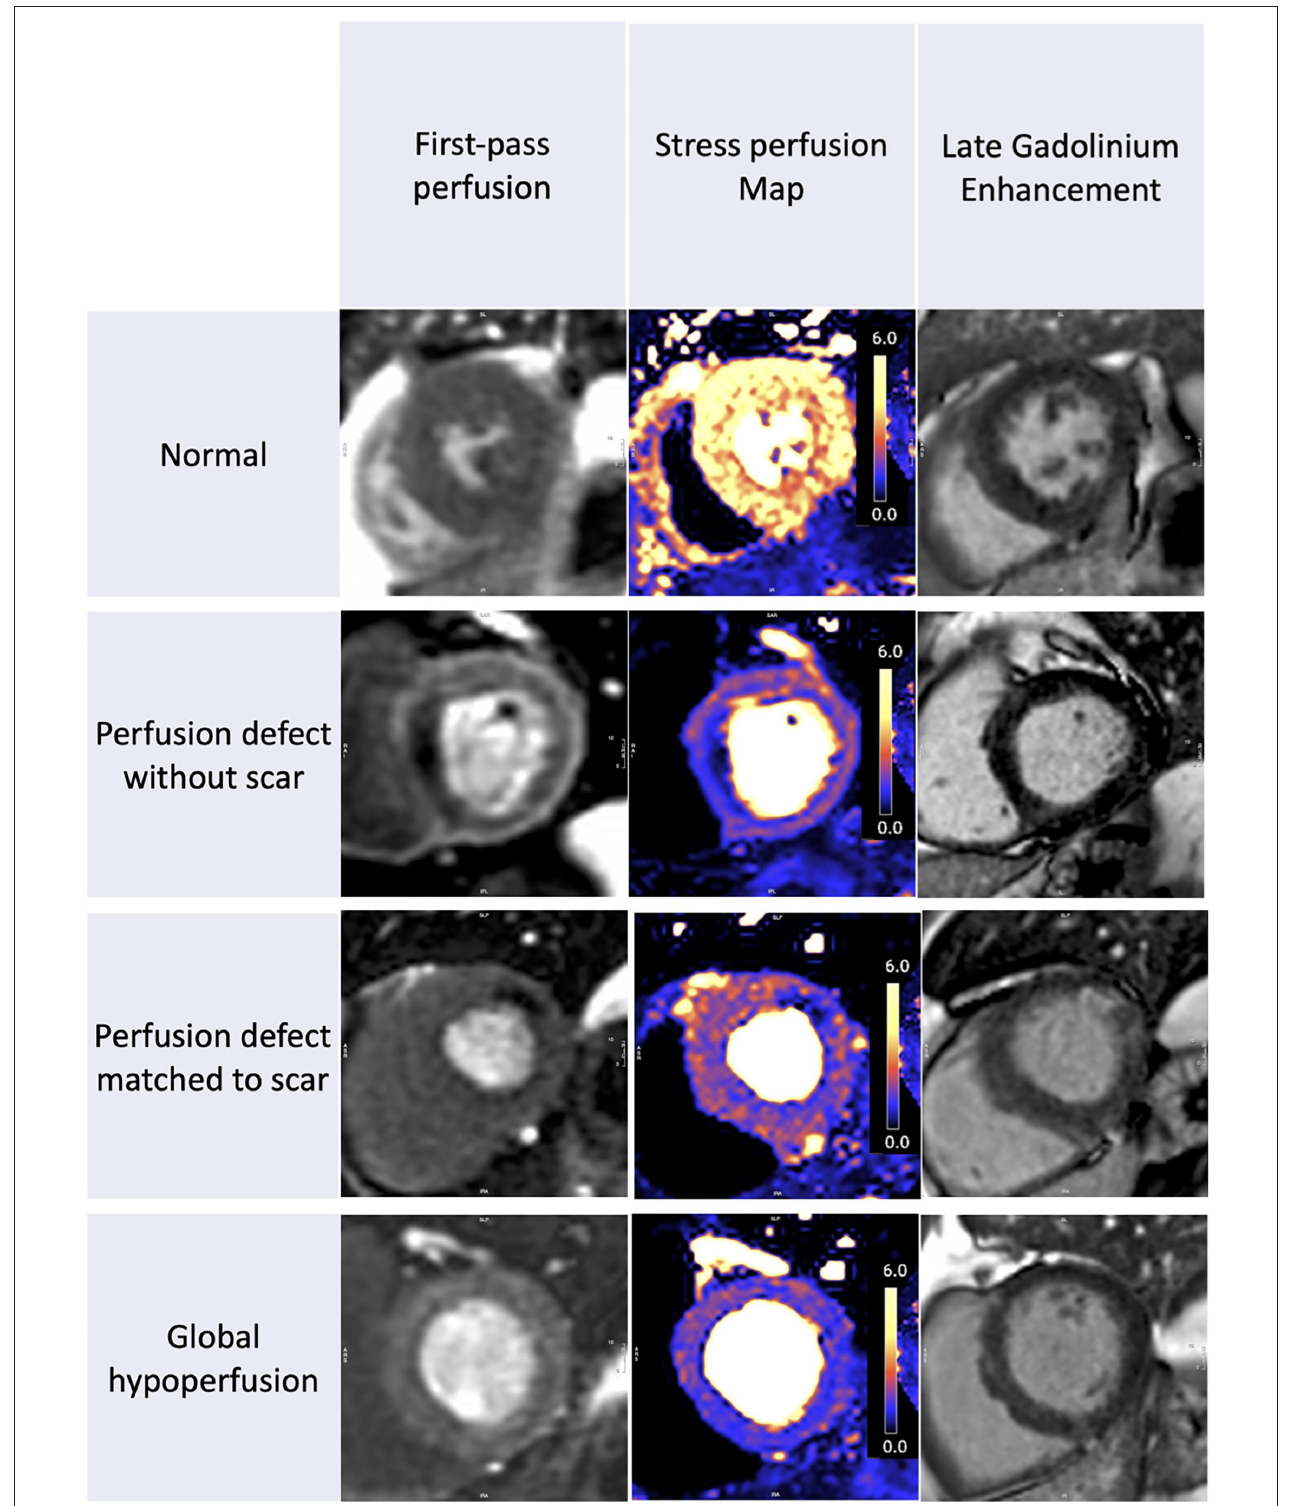
FIGURE 1 | Stress perfusion and scar in recovered COVID-19 patients. The spectrum of perfusion abnormalities. From left to right we show the first-pass perfusion images, quantitative stress perfusion maps, and free breathing-phase sensitive inversion recovery and motion corrected late gadolinium enhancement images (PSIR MOCO LGE). Patient 1: Normal. Patient 2: Regional ischemia without LGE. Patient 3: Regional ischemia with infarct late gadolinium enhancement (LGE). Patient 4: Global hypoperfusion without visual perfusion defects and no significant LGE.